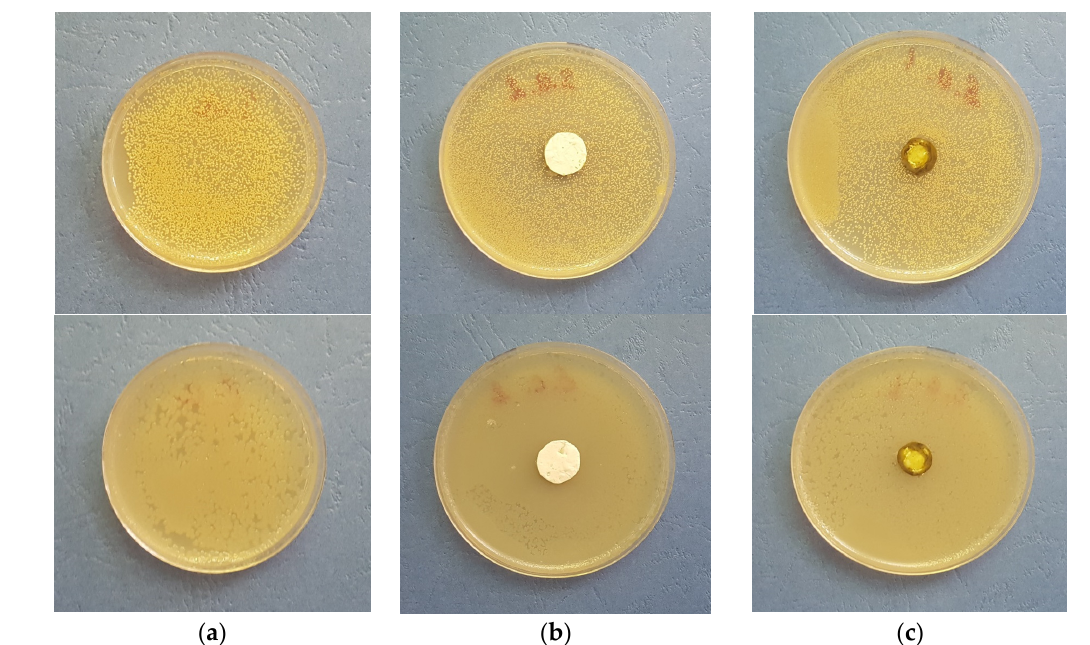
Figure 6. Digital photographs of ( a ) control bacteria; ( b ) PLA mat; and ( c ) PLA/ P. oleracea mat after 24 h with S. aureus and E. coli . The cell type is marked in the left of each row.